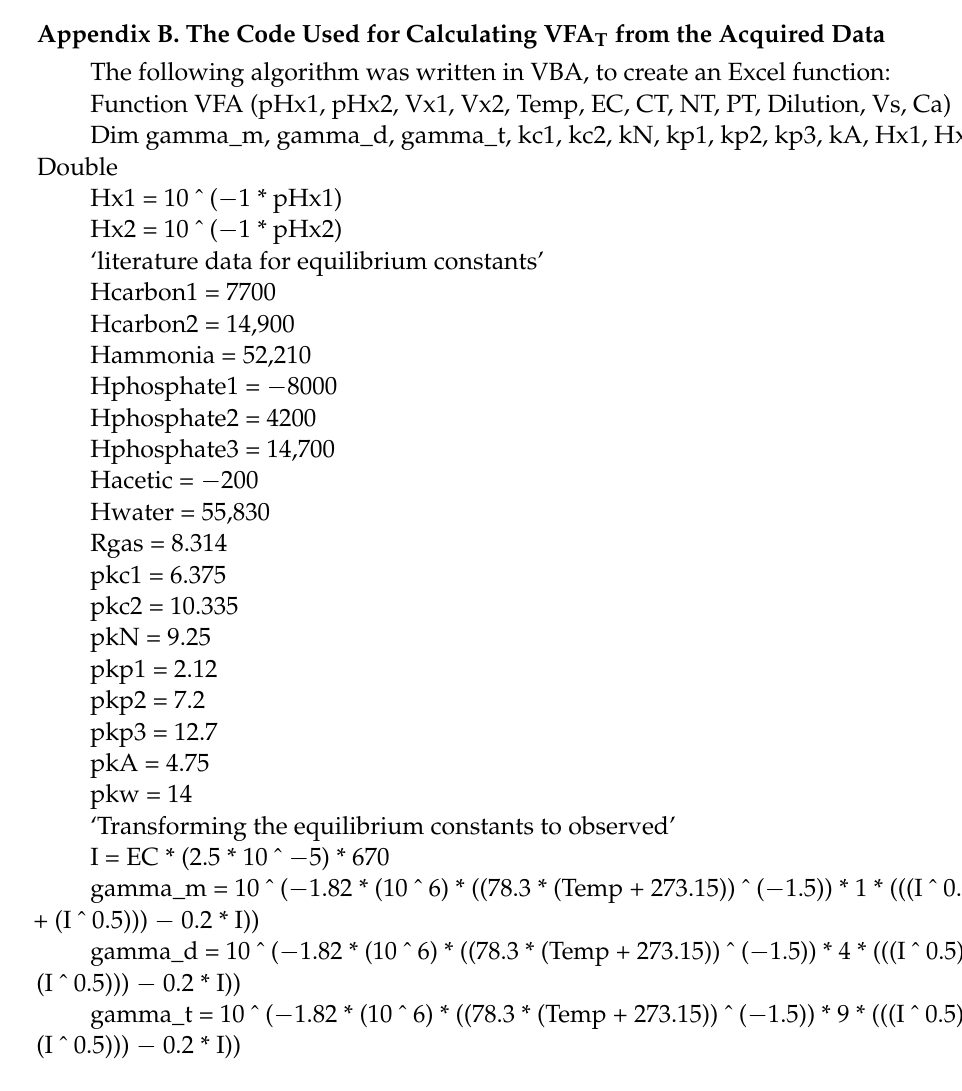
Figure A1. A sealed beaker with inlet holes for electrodes and for the acid titration tubing.